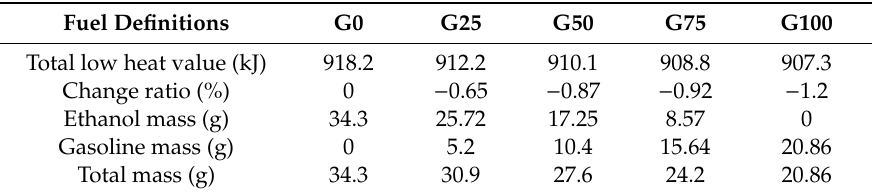
Table 6. Total fuel heat value at λ =